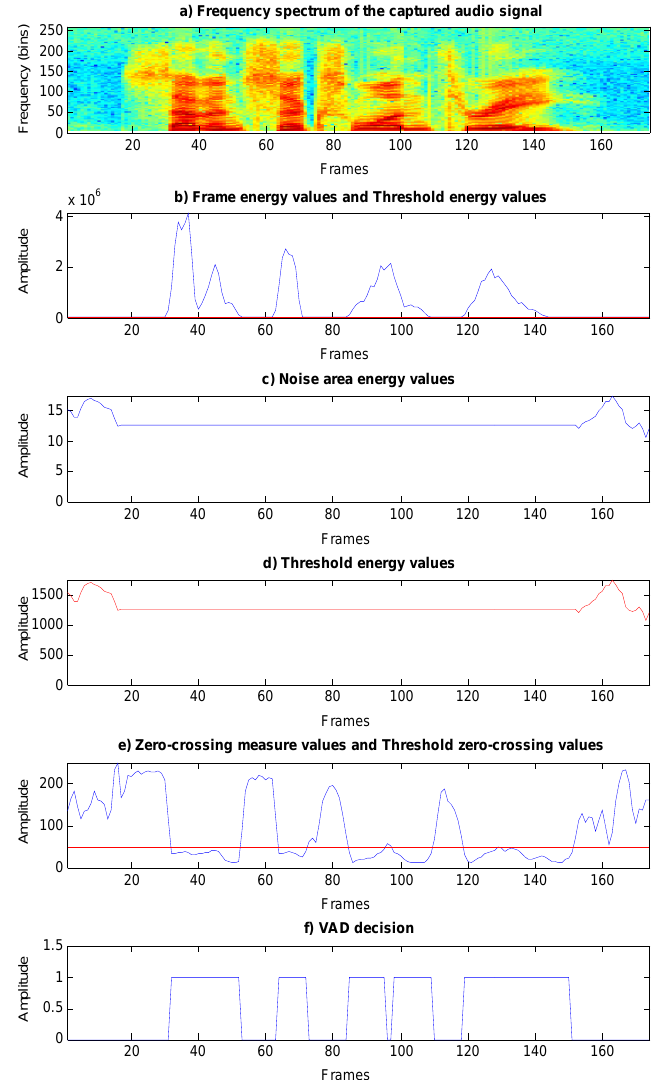
Figure 2. VAD decision determination: ( a ) Captured audio signal frequency spectrum. ( b ) Frame energy values and threshold energy values. ( c ) Noise area energy values. ( d ) Threshold energy values. ( e ) Zero-crossing measure values and threshold zero-crossing values. ( f ) VAD decision.